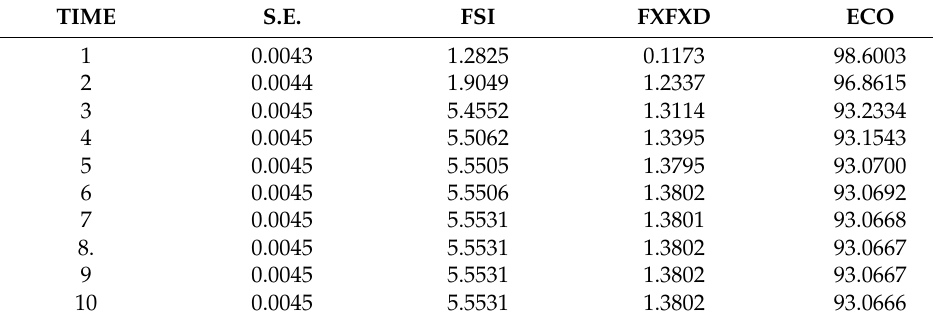
Table A1. Variance decompositions of ECO.